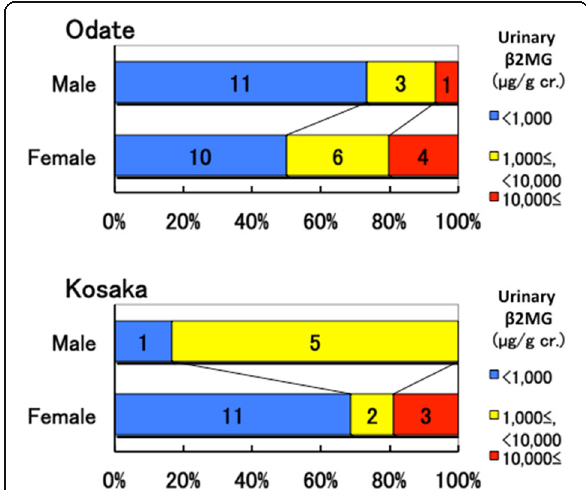
Fig. 2 Distribution of blood and urinary cadmium levels among 35 and 22 subjects in Akita Rosai Hospital in Odate city (Odate) and Kosaka Clinic in Kosaka town (Kosaka), respectively. The actual numbers are presented in the